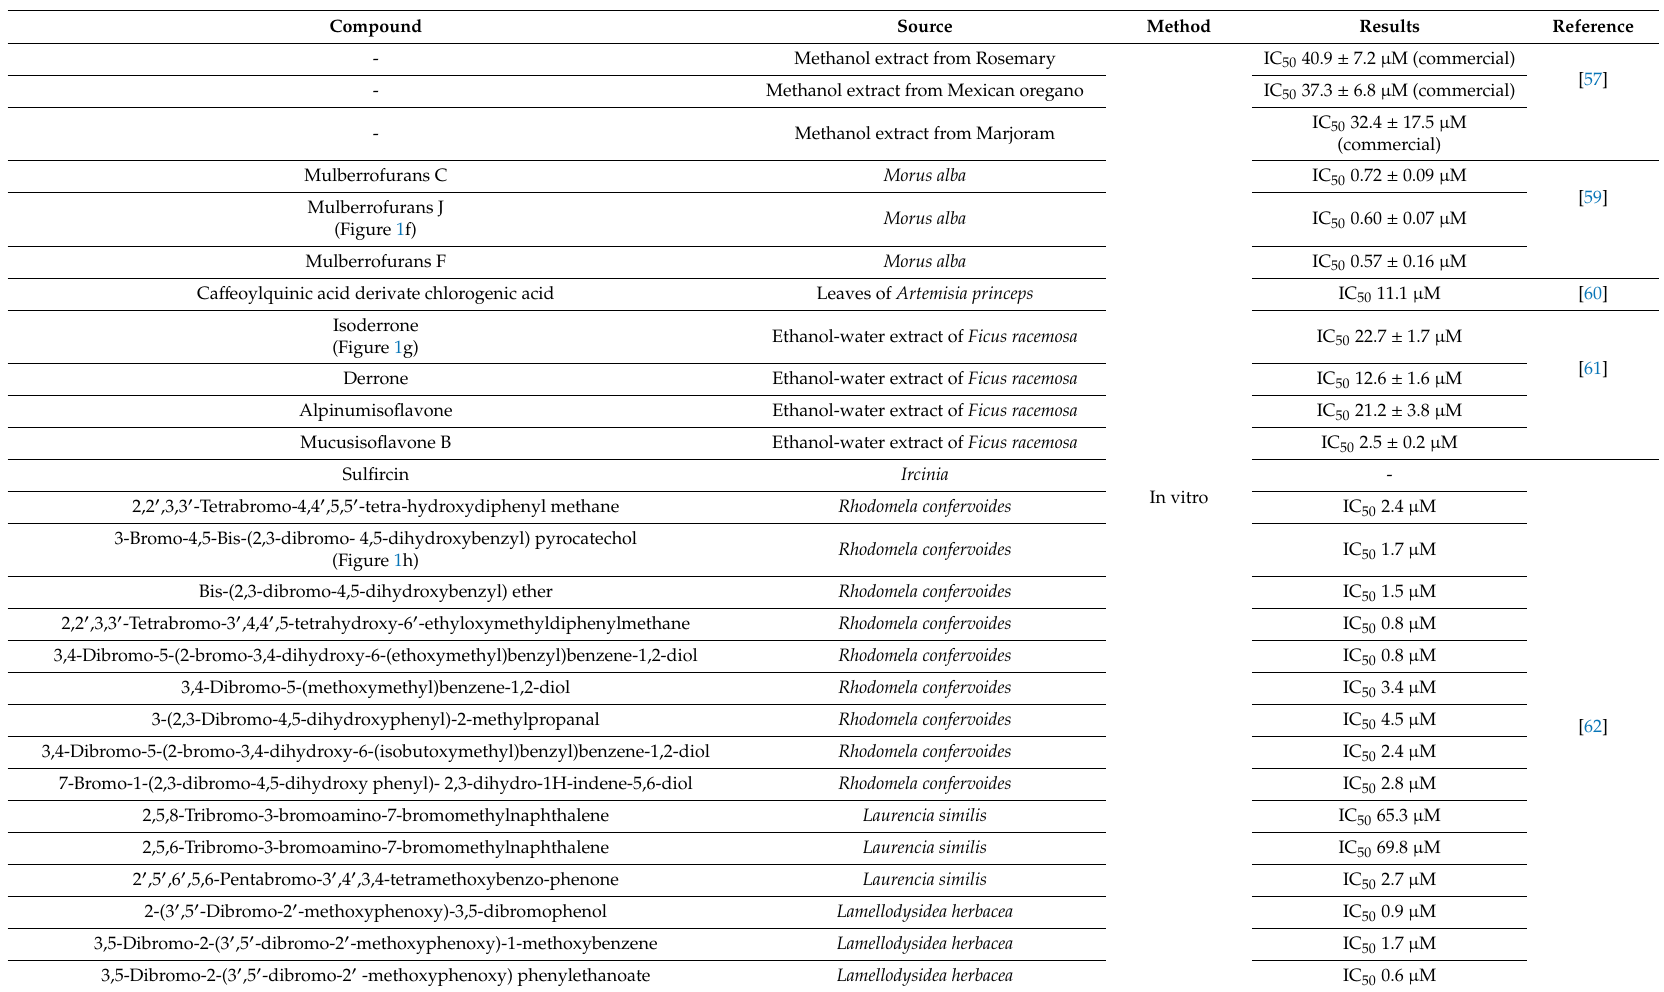
Table 2. Natural PTP1B